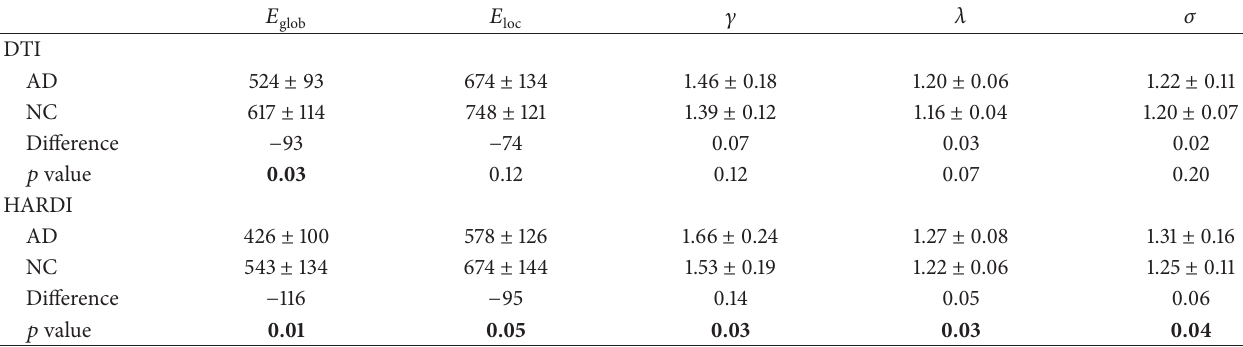
Table 3: The comparison of the global connectivity characteristics between the AD and the NC groups with the DTI and HARDI models,